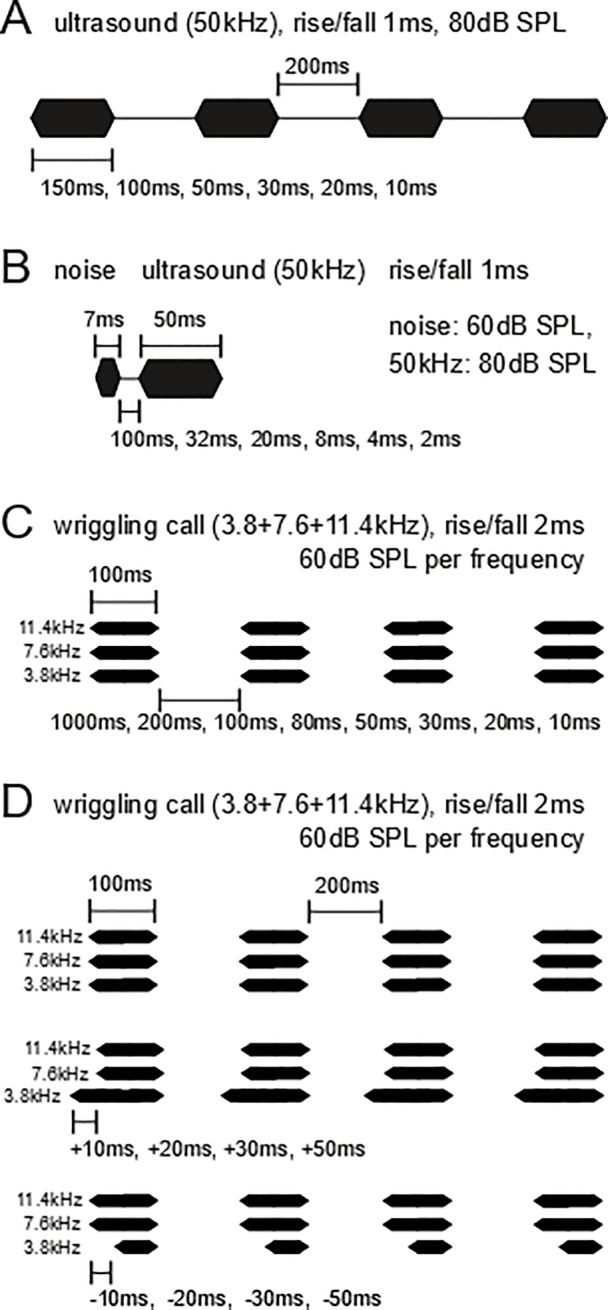
Schemes of the acoustic properties of the sounds used in the four experiments (A-D). In all experiments, the timing is varied as indicated: In (A), the tone duration in the series of four 50 kHz tones (models of mouse pup ultrasounds); in (B), the inter-stimulus interval (ISI) between the noise burst and the 50 kHz ultrasound; in (C), the ISI between the series of four models of mouse pup wriggling calls, each composed of three harmonics; in (D), series of four models of mouse pup wriggling calls with either simultaneous start of the three harmonics, or advanced or delayed start (with the indicated times) of the first harmonic (3.8 kHz).